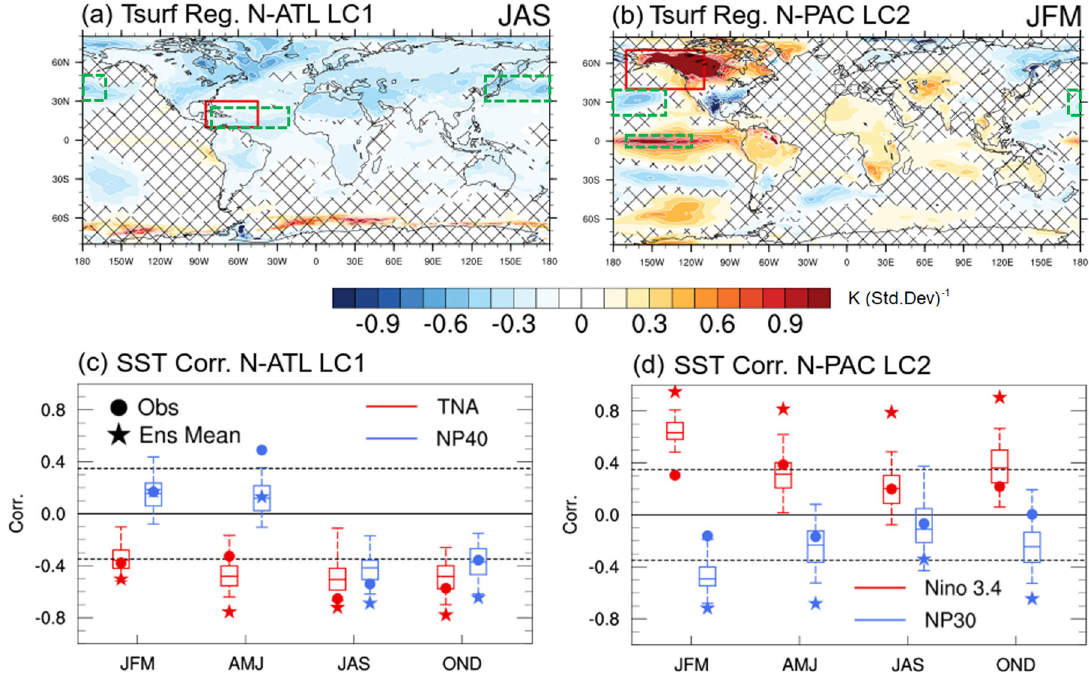
Fig. 3 Relationships between baroclinic waves and surface temperature in d4PDF simulation. a , b Linear regression (color shading) of ensemble-mean surface temperature (K) onto ensemble-mean BWA (standardized) during 1979 – 2010. The ensemble-mean BWA of a N-ATL LC1 and b N-PAC LC1 (red boxes) are event counts that are standardized based on year-to-year variations. Hatching in a , b indicates the linear relationship is below 95% con fi dence determined from a non-directional t -statistics. c , d Linear correlations between regional surface temperature and BWA. The surface temperature metrics are SSTs of the tropical North Atlantic (TNA; 10 – 25°N, 20 – 80°W) and the midlatitude North Paci fi c (NP40; 30 – 50°N, 130°E – 160°W) for c N-ATL LC1 events; and the SST of Niño 3.4 region (120 – 170°W, 5°S – 5°N) and the midlatitude North Paci fi c (NP30; 20° – 40°N, 170°E – 140°W) for N-PAC LC2 events. The boxplots indicate 2.5th, 25th, 50th, 75th, and 97.5th percentiles of correlations in individual ensemble members. Dots and stars show the correlations of the ERA-Interim reanalysis and the ensemble means, respectively. The black dotted line shows the 5% signi fi cance level determined from the t-statistics. The horizontal axis denotes results from January – March, April – June, July – September, and October –